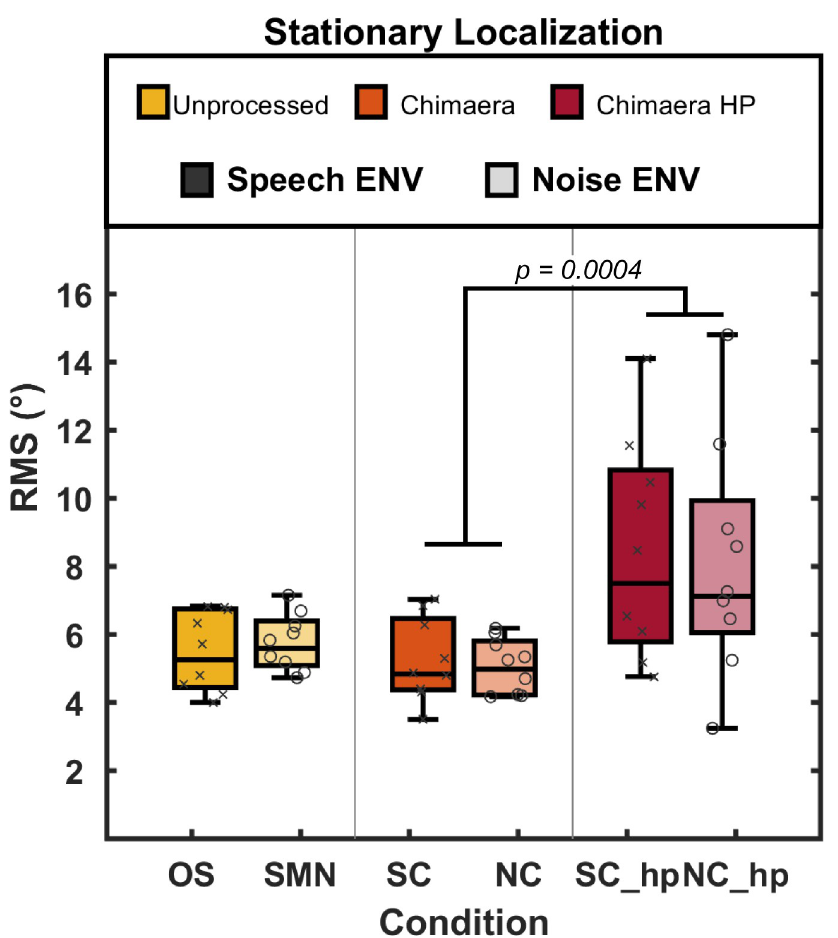
Fig 1. RMS errors for stationary sound localization. RMS errors (y-axis) collected during stationary sound localization testing across conditions (x-axis) are plotted as boxplots with group medians (black line) and individual data (individual markers) superimposed. Data are organized by stimulus category (color legend), and ENV type is indicated by color intensity (legend).